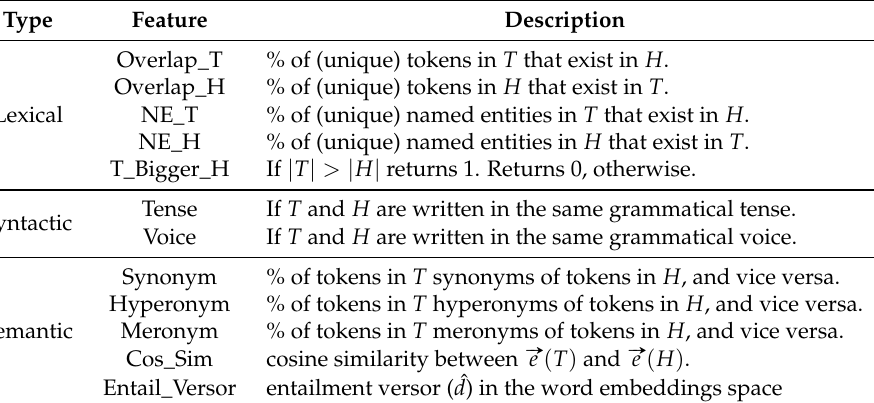
Table 4. Feature